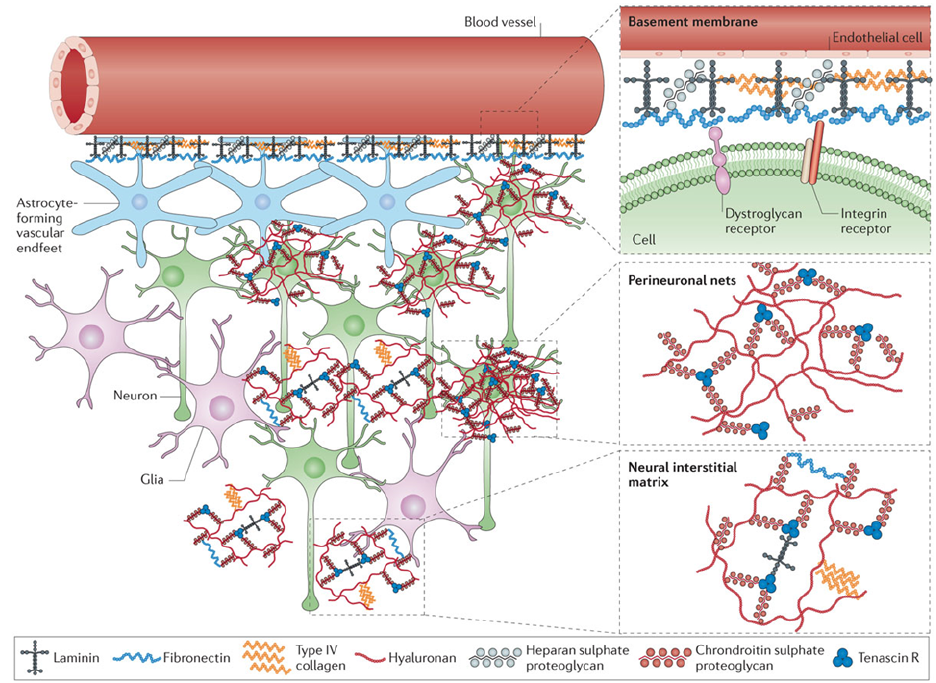
Figure 2. Extracellular matrix (ECM) components are arranged into basement membranes that lie outside cerebral vessels, condensed as perineuronal nets around the cell bodies and dendrites of neurons or diffusely distributed as the neural interstitial matrix between cells of the CNS parenchyma. The pink glial cells depict astrocytes, oligodendrocytes or microglia. This figure has been reproduced from [80] with permission from Springer